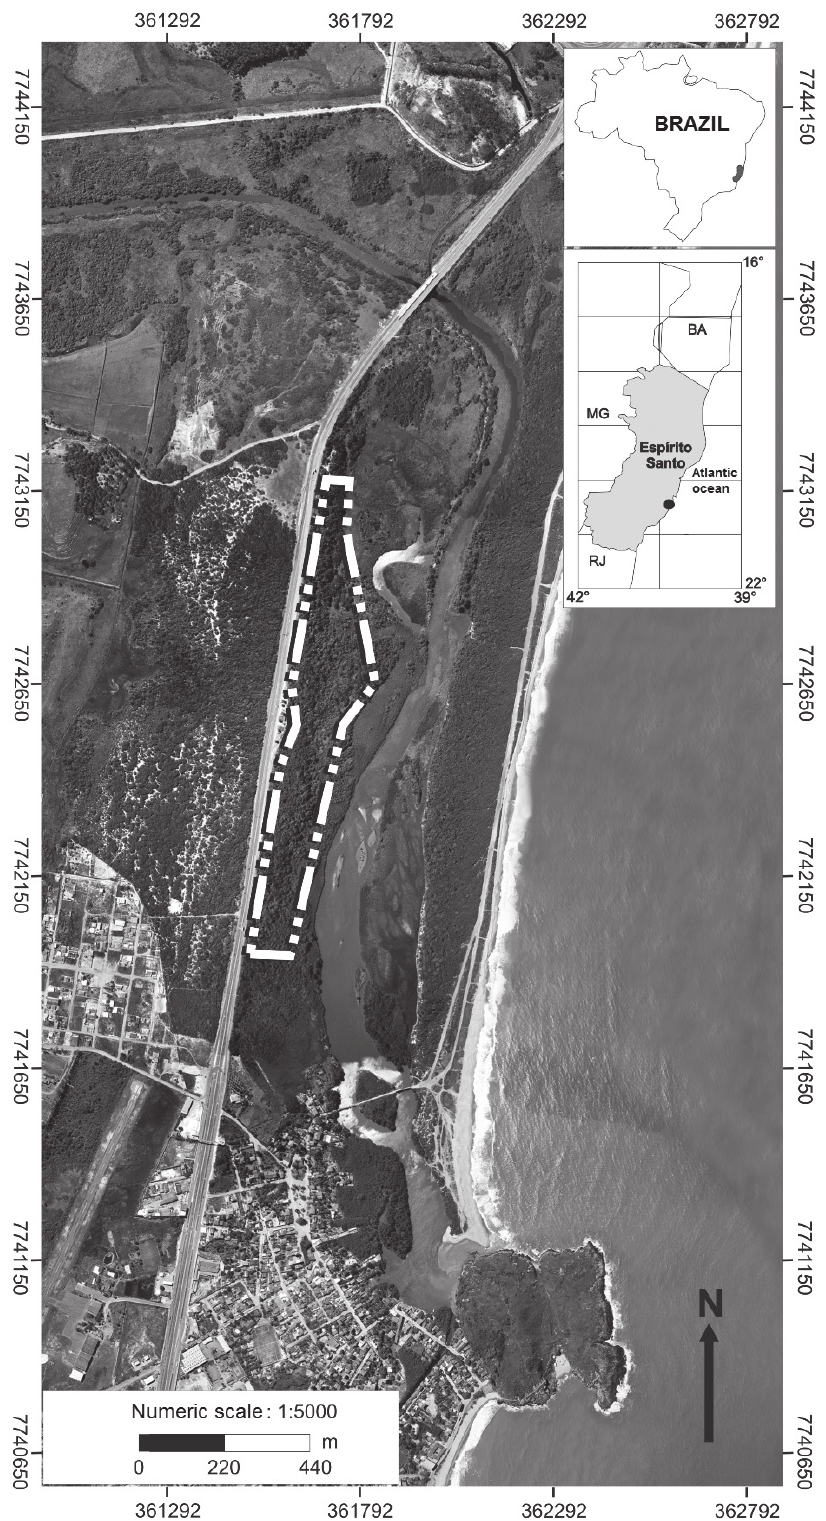
Figure 1 - Location of Jacarenema Natural Municipal Park, Vila Velha/ES with the the studied areas